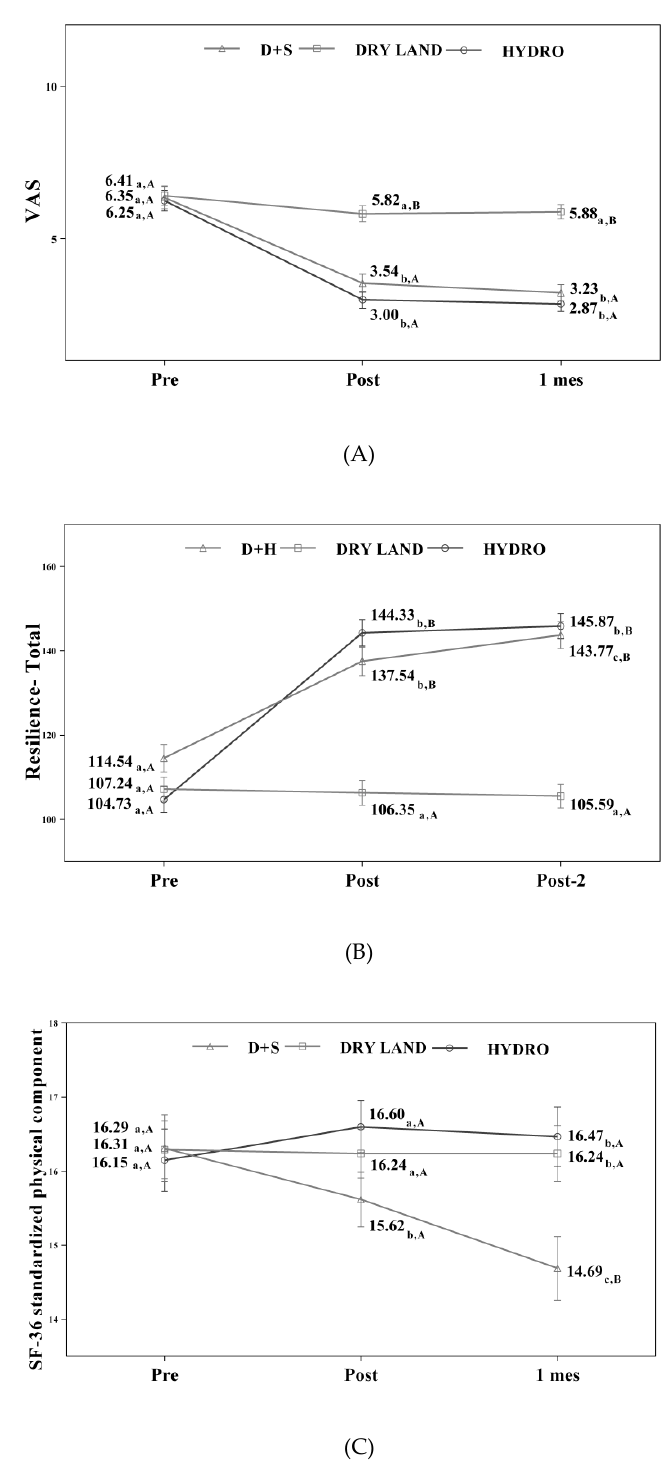
Figure 2. ( A ) Values of the VAS scale; ( B ) Values of the resilience scale; ( C ) Values of the SF-36 scale Figure 2. (A) Values of the VAS scale; (B) Values of the resilience scale; (C) Values of the SF-36 scale standardized physical component; D + S: combined therapy standardized physical component; D+S: combined therapy group.